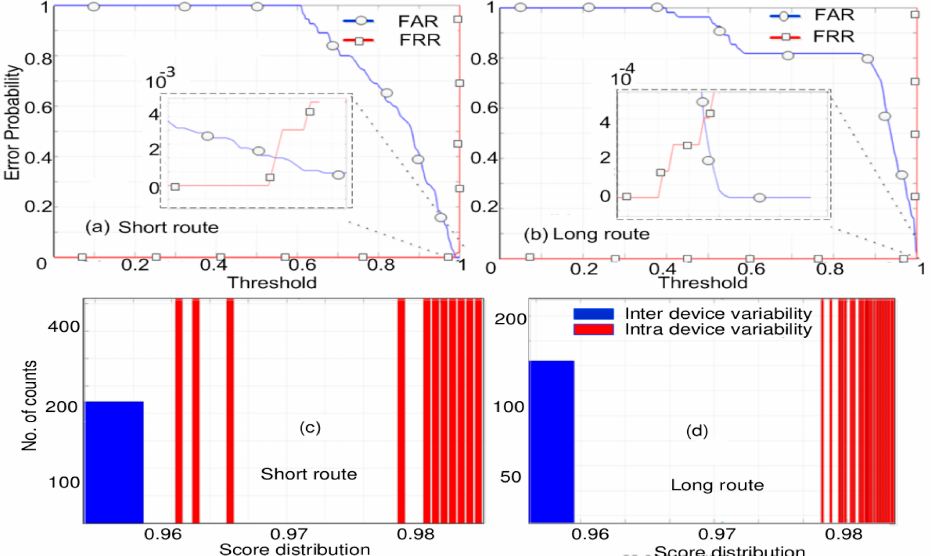
Figure 8. The error probability curves showing the distinction and overlap between false acceptance rate (FAR) and false rejection rate (FRR) with inset zoom on overlap of FAR and FRR. ( a ) Error probability curve for short route. ( b ) Error probability curve for long route. ( c ) Histogram describing the inter and intra variability for short route. ( d ) Histogram showing intra and inter variability for long route.